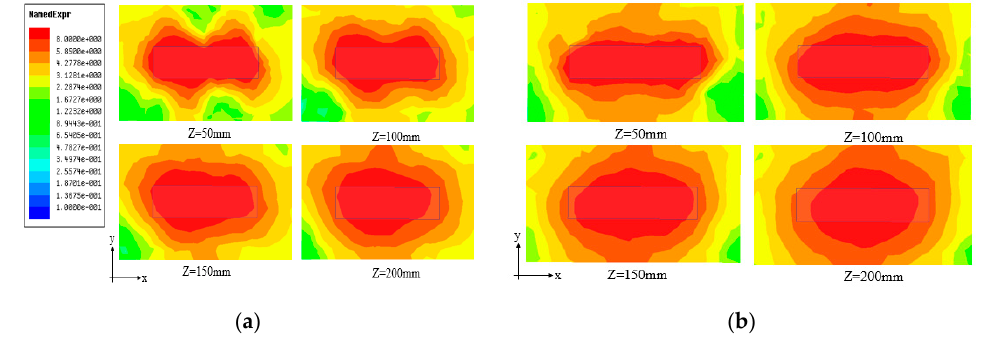
Figure 27. Simulated distribution of electric field components (Ex, Ey) at different heights for a 1 × 4 array antenna: ( a ) Ex distribution and ( b ) Ey distribution.